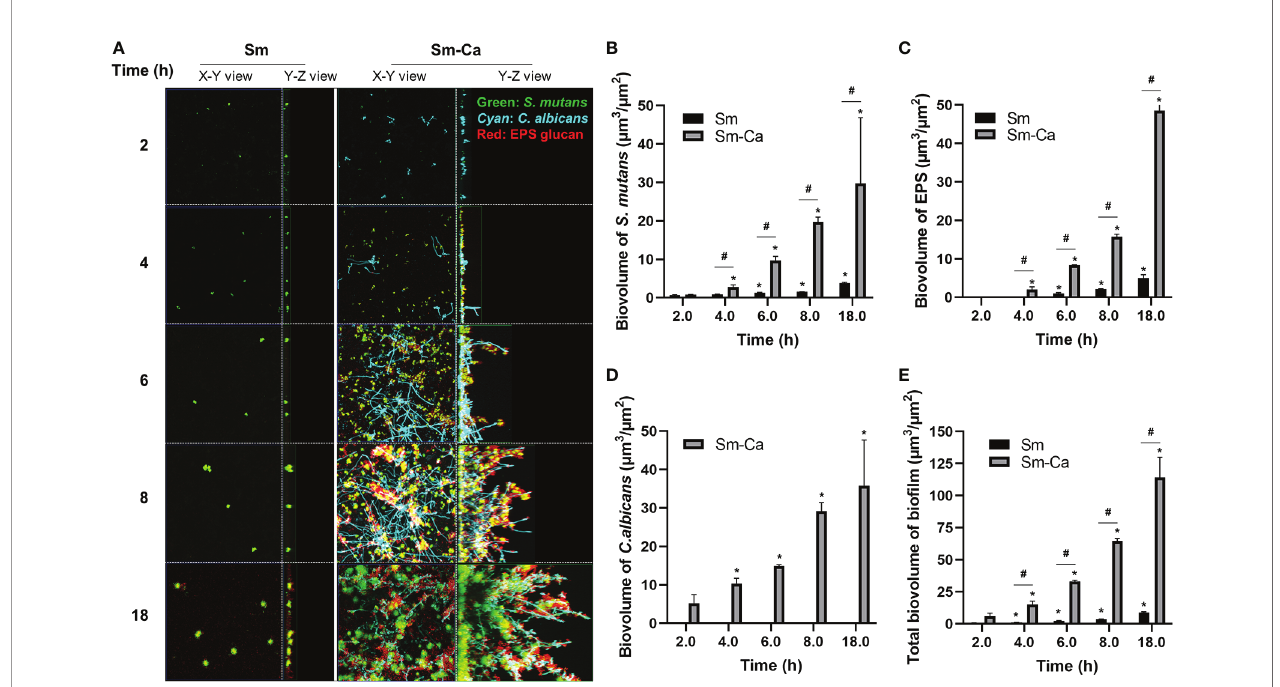
FIGURE 3 | Confocal images of bio fi lms and quanti fi cation of bio fi lm components. (A) Representative top (X – Y) and orthogonal (Y – Z) views of confocal images of Sm and Sm-Ca bio fi lms at 2, 4, 6, 8, and 18 h cultured under SAL 100 . Bacterial cells are labeled with SYTO 9 (green), fungal cells with concanavalin A- tetramethylrhodamine (Cyan), and EPS a -glucan with Alexa Fluor 647 (red). Quanti fi ed biovolume of (B) S. mutans , (C) EPS, (D) C . albicans , and (E) total (sum of S. mutans , C . albicans , and EPS) in the bio fi lm. Asterisk indicates that the p -values are signi fi cantly different from the biovolume of 2 h (ANOVA with Dunnett; * P < 0.05). Hash indicates that the p -values are signi fi cantly different between two groups ( t -test # P < 0.05).